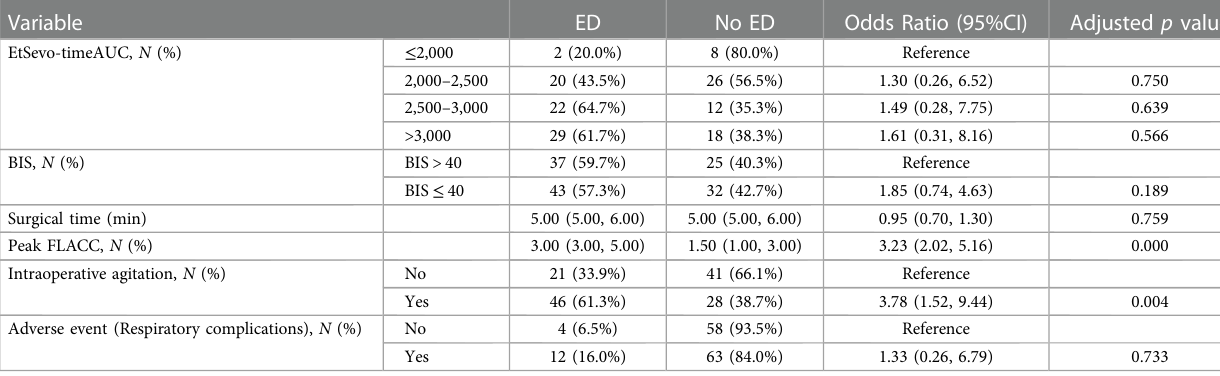
TABLE 4 Multivariable logistic regression model for emergence delirium.